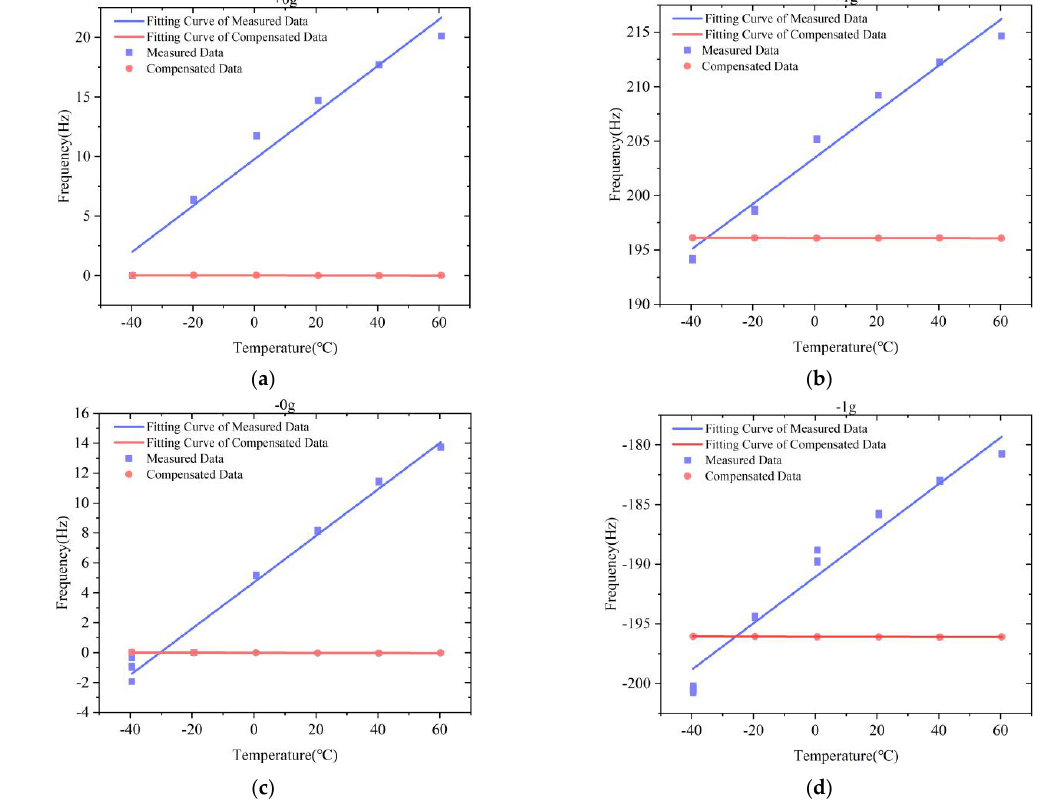
Figure 10. The IFA-BP compensation results of test dataset 2 in the full-temperature experiment: ( a ) +0 g; ( b ) +1 g; ( c ) −0 g; ( d ) −1 g.